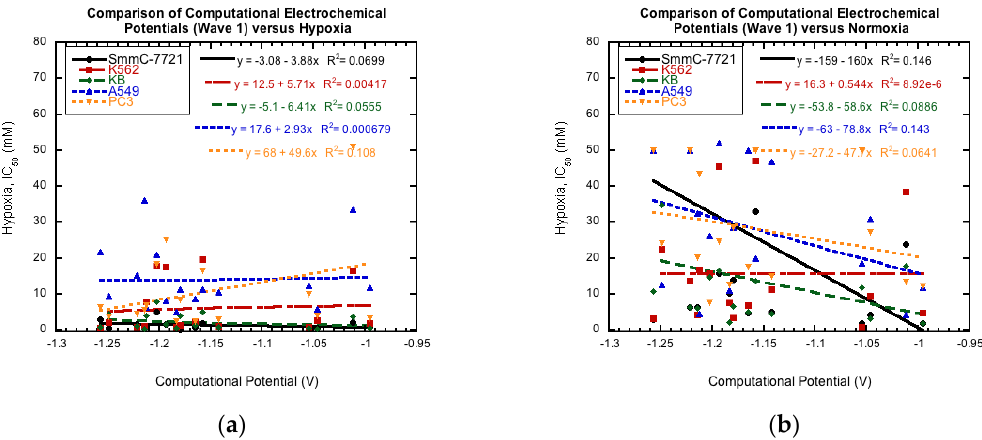
Figure 10. The computationally predicted reduction potentials from lanl2dz for Wave 1 (1st N-oxide reduction) and compared to the previously reported IC50 (µM) for five cancer cell lines [26] under (a) hypoxic and (b) normoxic conditions for A1–D4. Hypoxia = 3% oxygen, Normoxia = 20% oxygen.